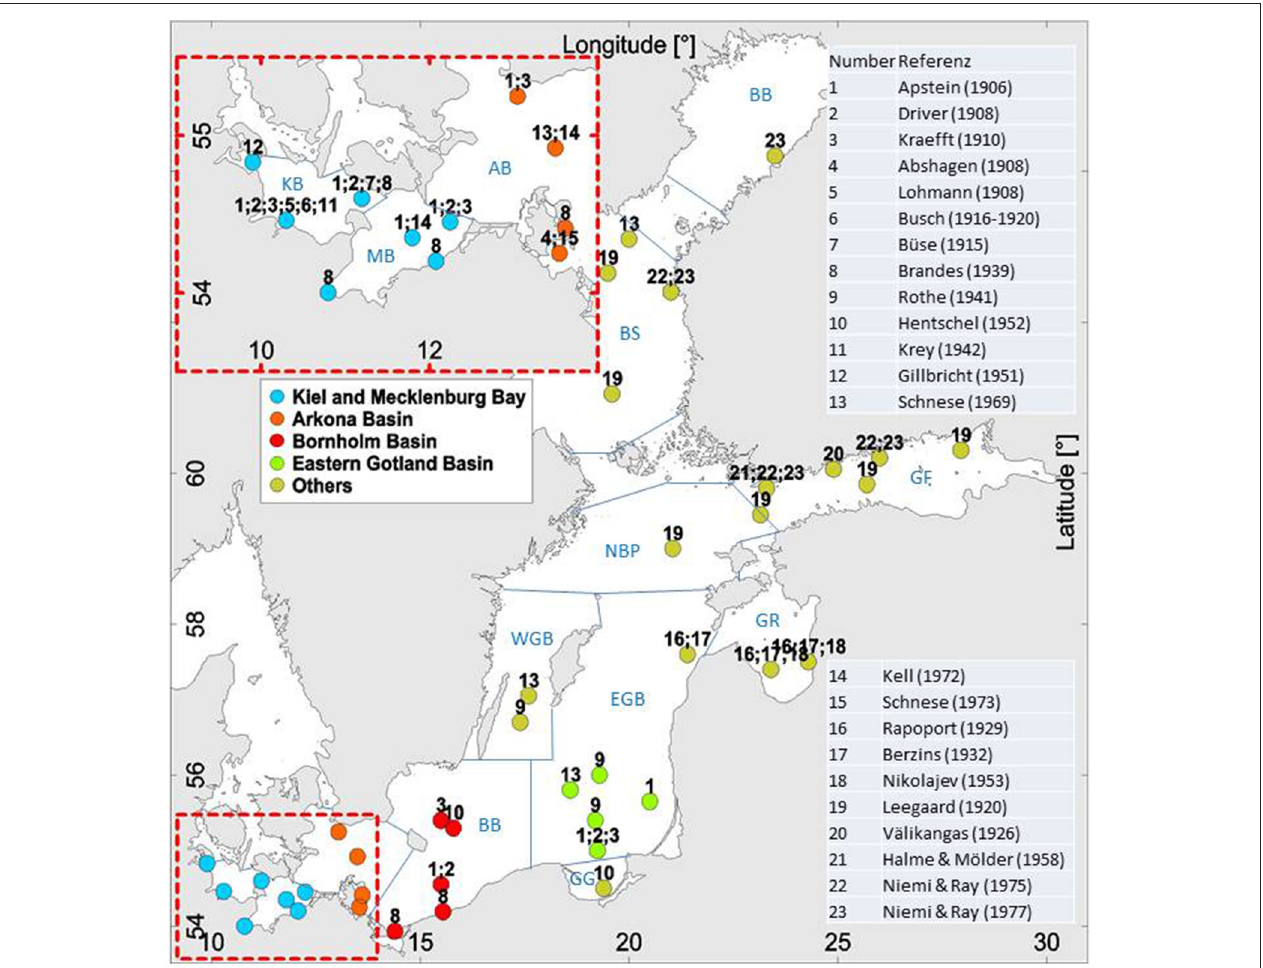
FIGURE 1 | The Baltic Sea with its sub-regions: KB, Kiel Bay; MB, Mecklenburg Bay; AB, Arkona Basin; BB, Bornholm Basin; GG, Gulf of Gda´nsk; EGB, Eastern Gotland Basin; WGB, Western Gotland Basin; NBP, Northern Baltic Proper; GR, Gulf of Riga; GF, Gulf of Finland; BS, Bothnian Sea; BB, Bothnian Bay. The numbers at the sampling locations relate to the references shown in the figure and listed in Table S1 . The details of Kiel and Mecklenburg Bays (combined into KMB) as well as Arkona Basin are given in the